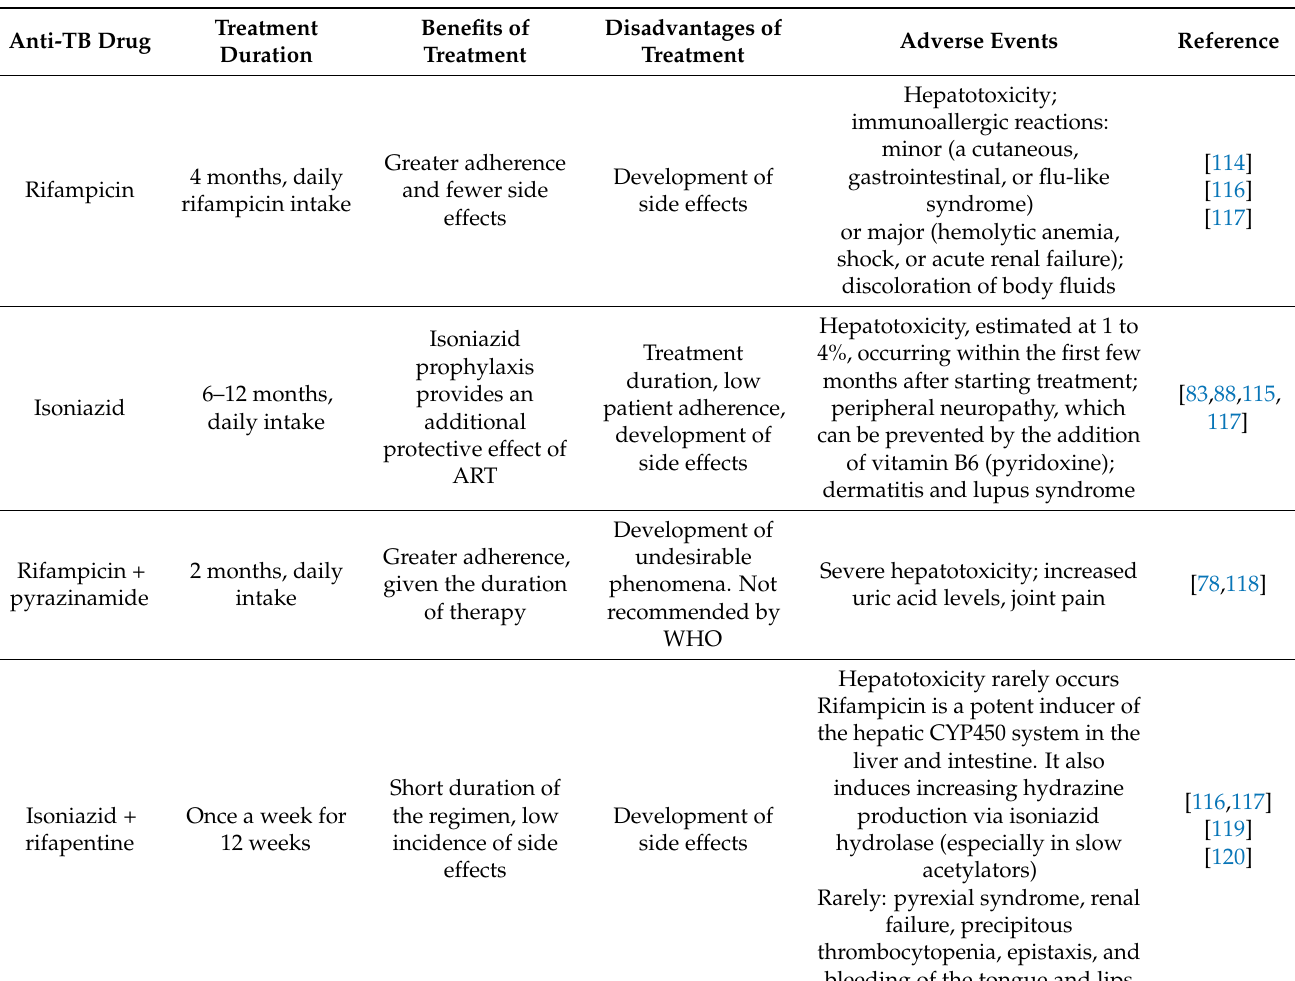
Table 2. Comparison of treatment regimens for the treatment of LTBI in world